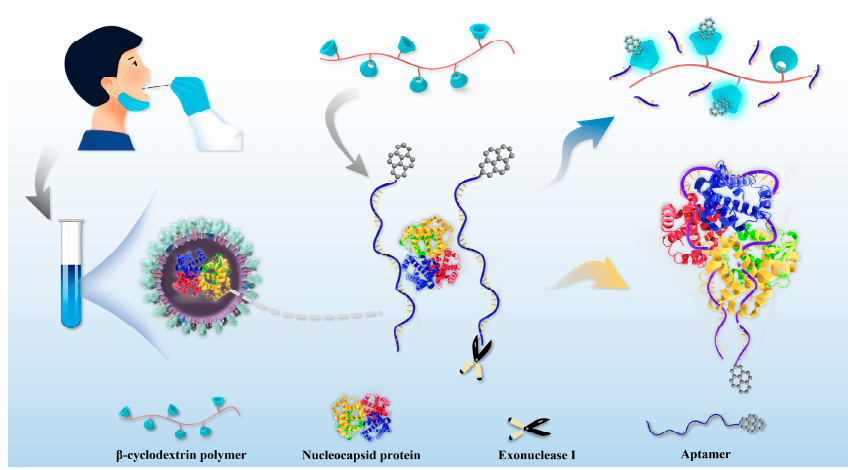
Figure 1. Schematic design of aptamer-based sensitive assay of SARS-CoV-2 N protein using β -cyclodextrin polymer to enhance pyrene fluorescence.